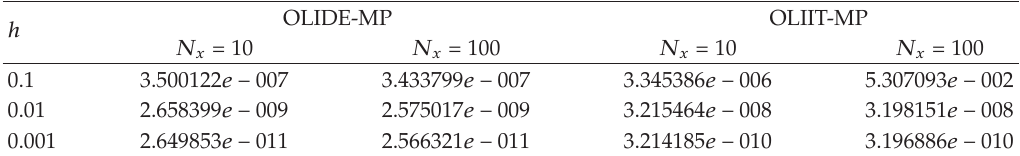
Table 3: The errors (cid:16) at t (cid:5) 10 when the algorithms are applied to the problem (cid:3) 5.6 (cid:4) with the coe ffi cients group II, where τ (cid:3) t (cid:4) (cid:5) 1.